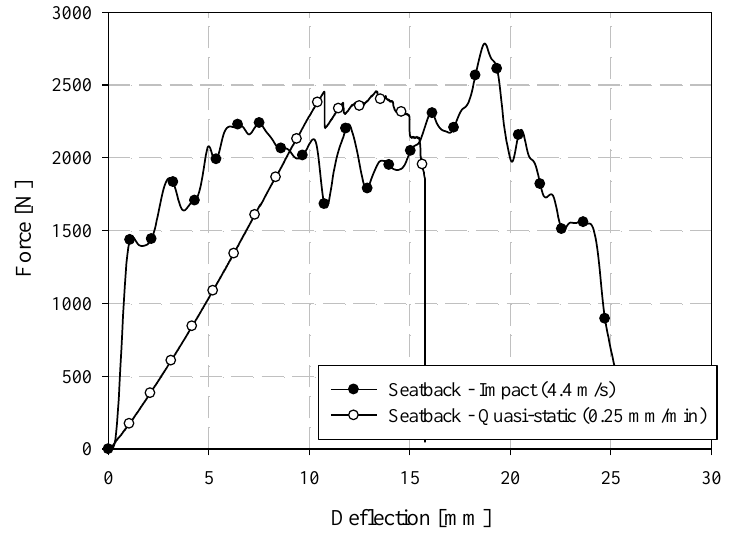
Figure 21. Comparison of quasi-static and low-velocity impact test force-deflection responses of carbon fibre LFT seatback components.